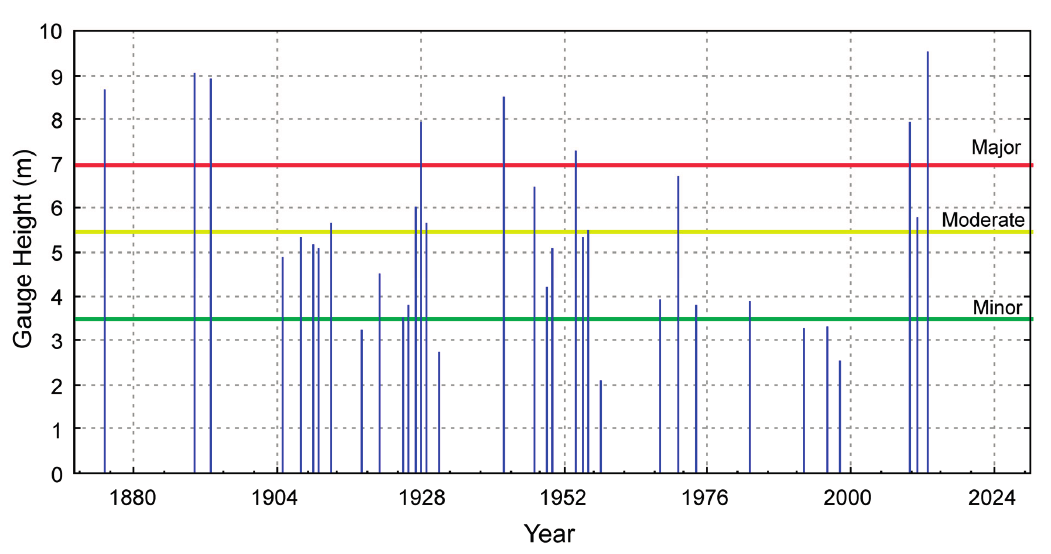
Figure 3. Highest annual flood peaks of the Burnett River on the southern Great Barrier Reef coast showing the 2013 flood led to the highest gauge height in the >130-year record (Generated on 4 April 2013 by the Australian Bureau of